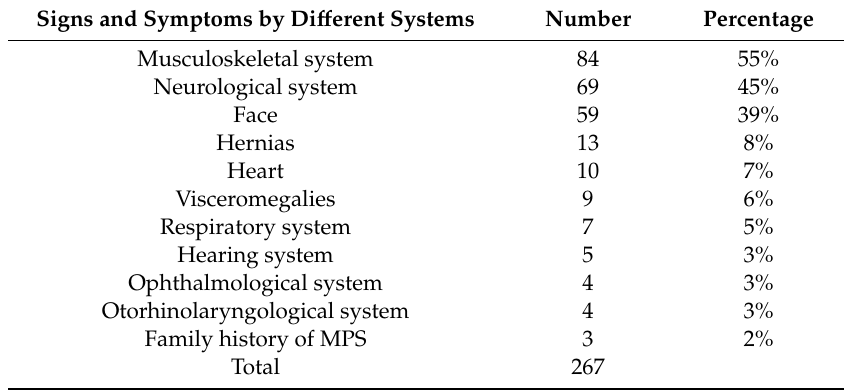
Table 3. Signs and symptoms by di ff erent systems recorded by health care professionals at the time of the decision to test the 153 subjects suspected of having mucopolysaccharidosis